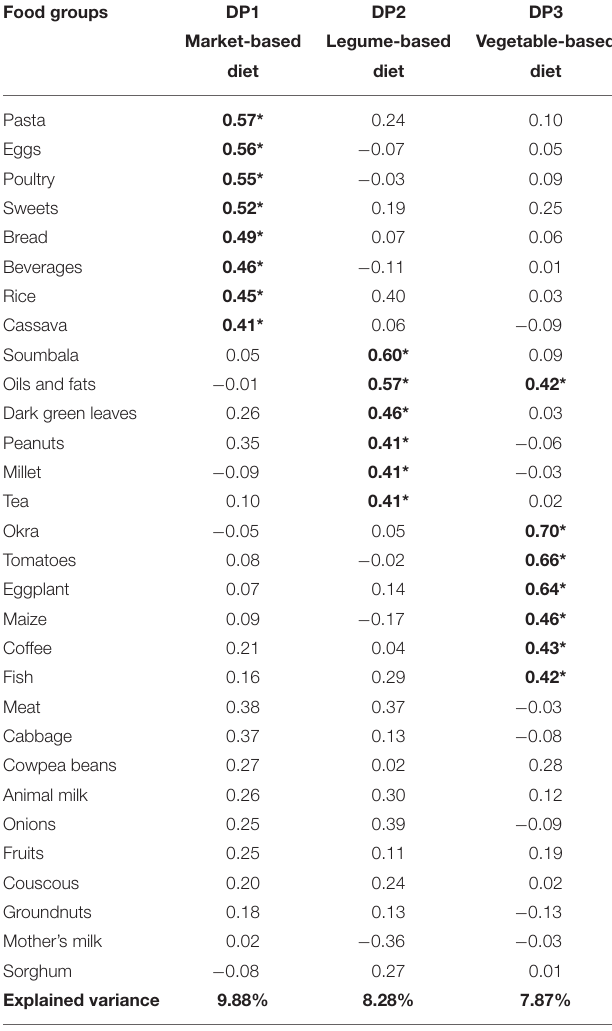
TABLE 2 | Rotated factor loadings of food items for the three dietary patterns among 1,439 children aged < 5 years in the Nouna HDSS area. Food